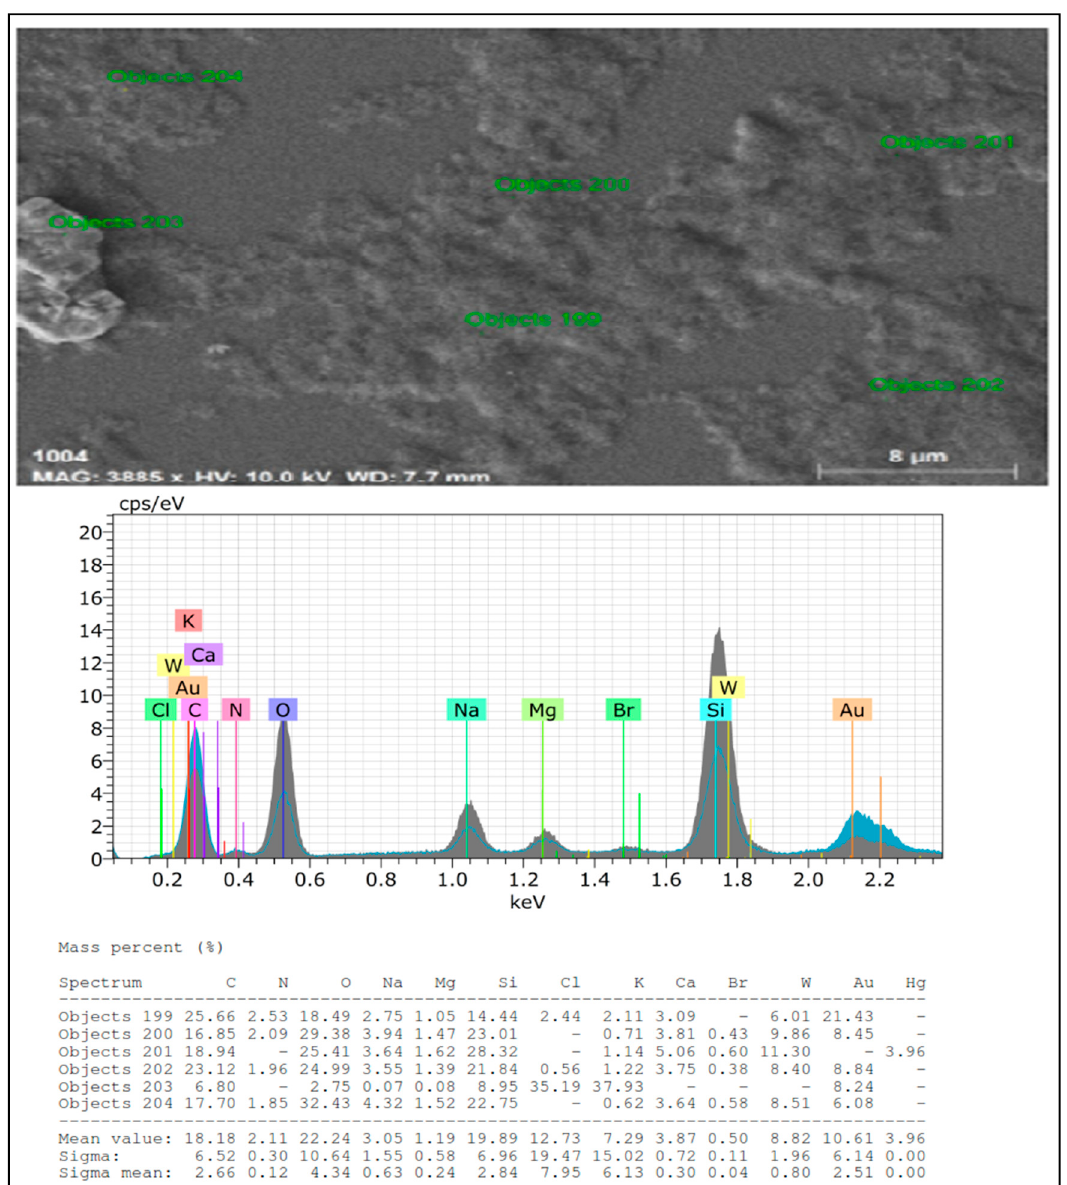
Figure 2. Energy-dispersive X-ray (EDX) spectra of green-synthesized AuNPs.